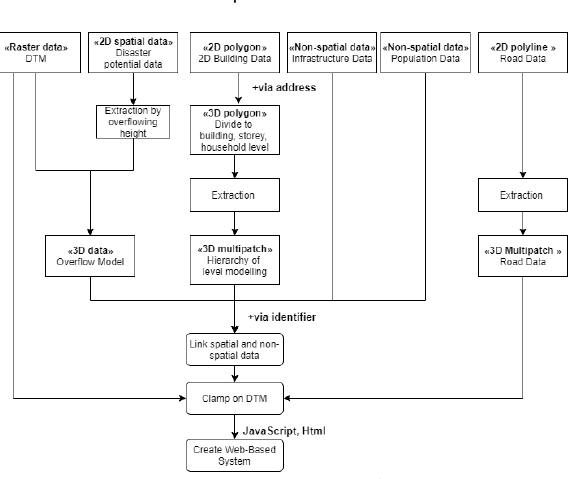
Figure 6. Data pre-processing flowchart